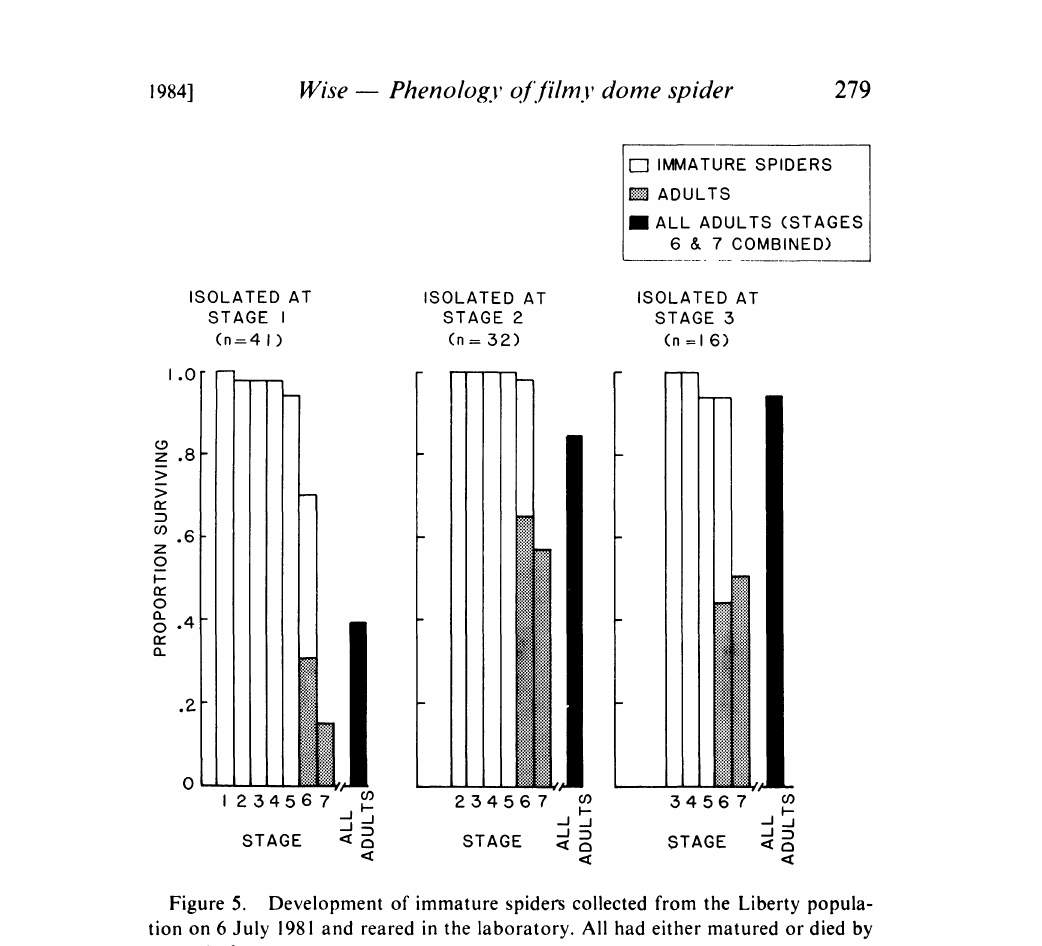
Figure 5. Development of immature spiders collected from the Liberty popula- tion on 6 July 1981 and reared in the laboratory. All had either matured or died by the end of